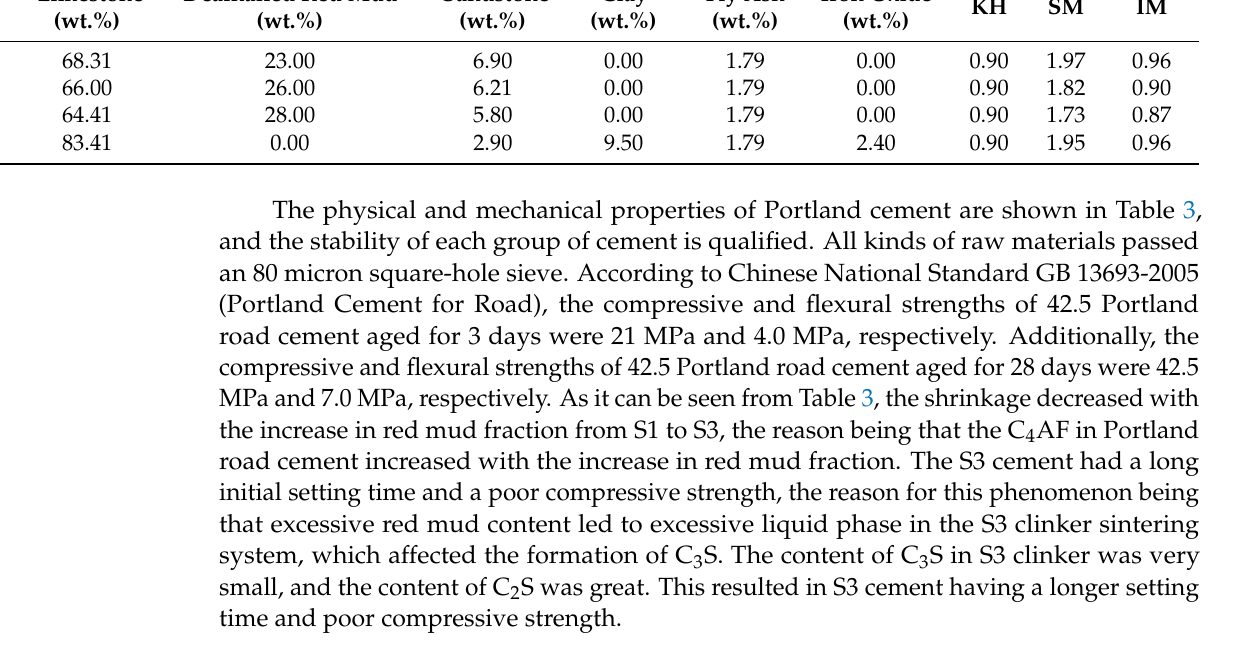
Table 3. Physical and mechanical performance of Portland cement for